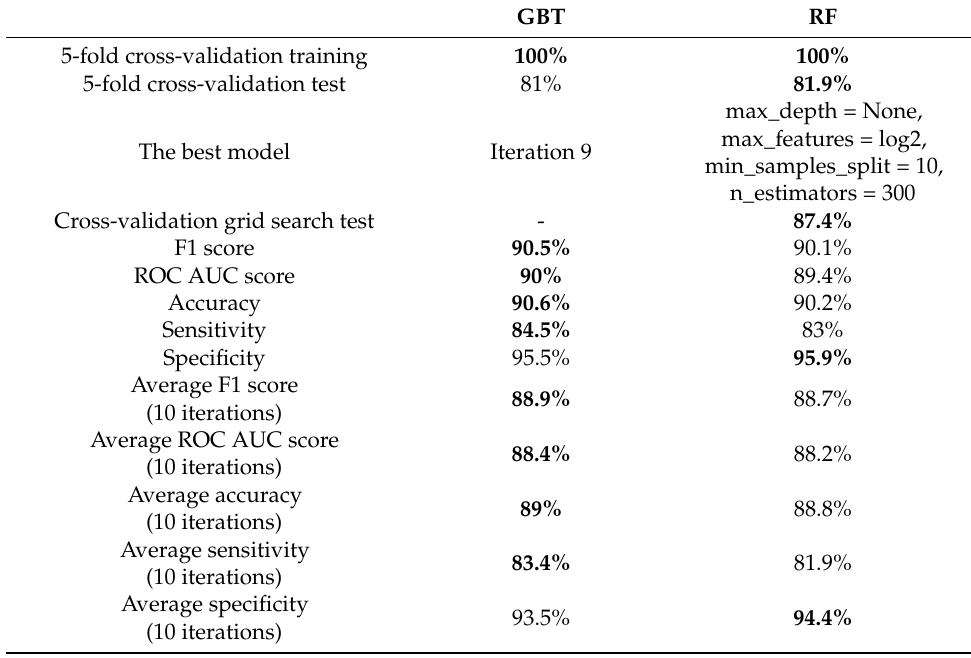
Table 2. Results of the DT algorithms applied on the non-overlapping dataset.